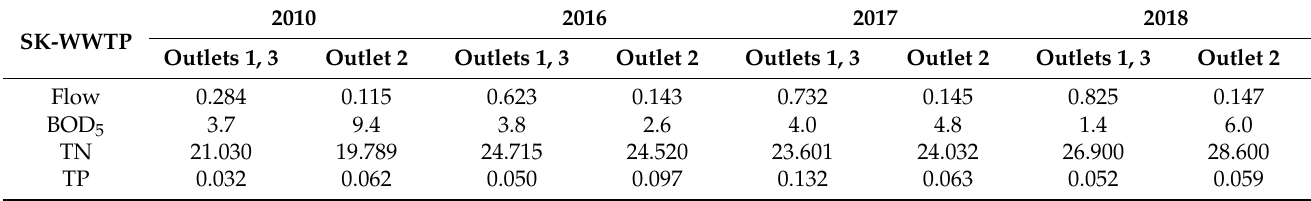
Table 4. Average daily discharge and water quality parameter values of the WWTP (flow, m 3 /s; water quality, mg/L).